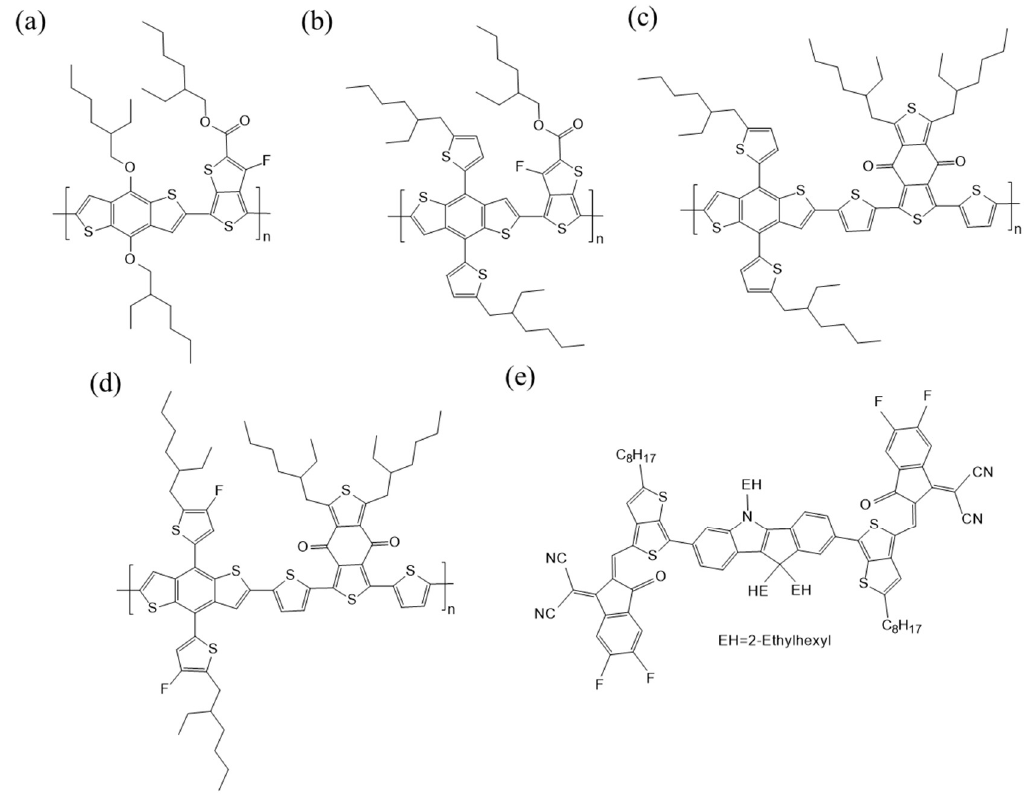
Figure 2. Chemical structures of ( a ) PTB7, ( b ) PTB7-Th, ( c ) PBDB-T, ( d ) PBDB-T-2F and ( e ) INTIC.